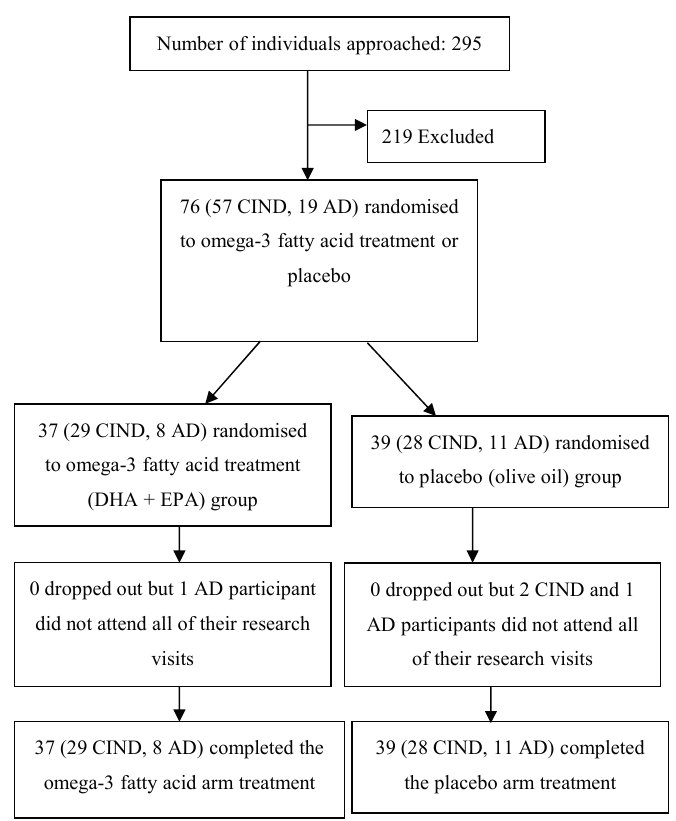
Figure 2. Flow diagram of progress of participants through the